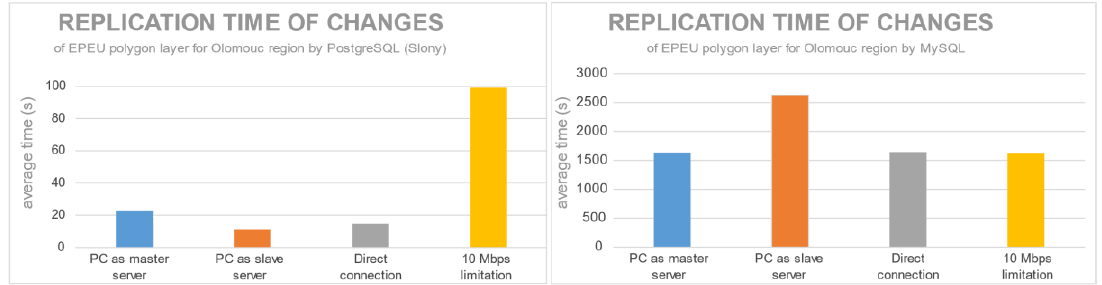
Figure 11. Replication time of the EPEU layer for different cluster configurations by MySQL. Table 4. Statistics analyses of the replication time of the EPEU layer for both replication solutions.